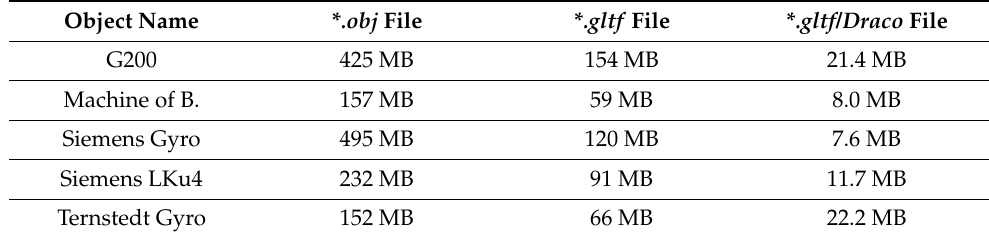
Table 5. Data volumes of different data